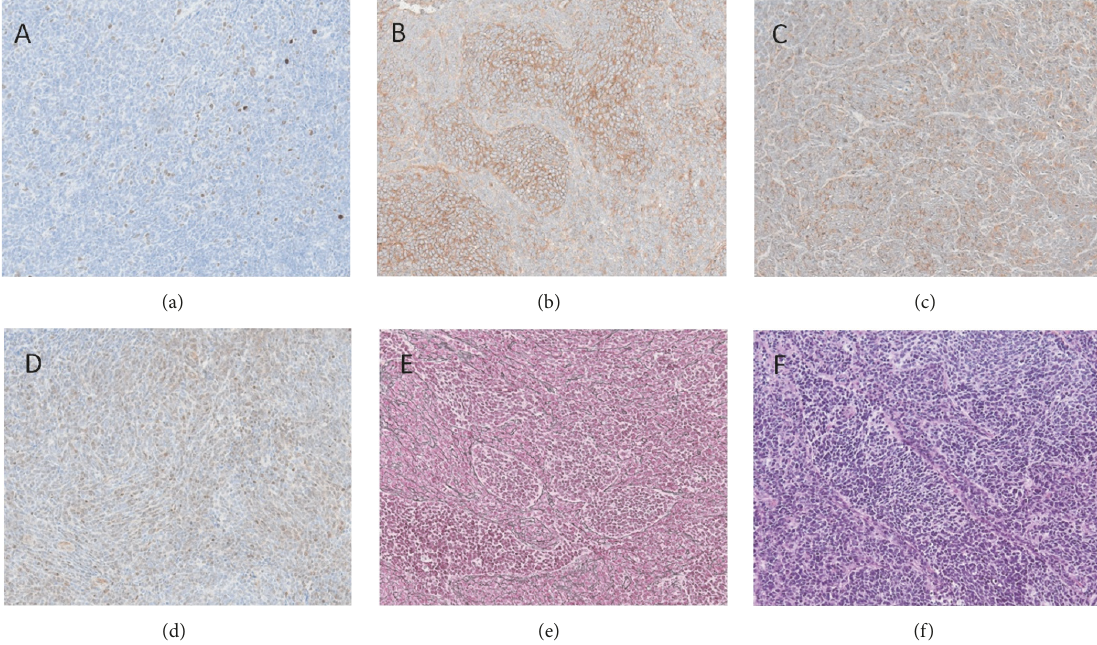
Figure 2: A small, round, blue cell, neuroectodermal tumor ((a), HE) showing a nodular architecture and a dense reticulin fiber network ((b), Gomori). Tumor cells showed nuclear expression of YAP1 (c) and cytoplasmic expression of GAB1 (d) while there was no nuclear expression of beta-catenin (e). Ki67-labelling reveals high proliferative activity (f).